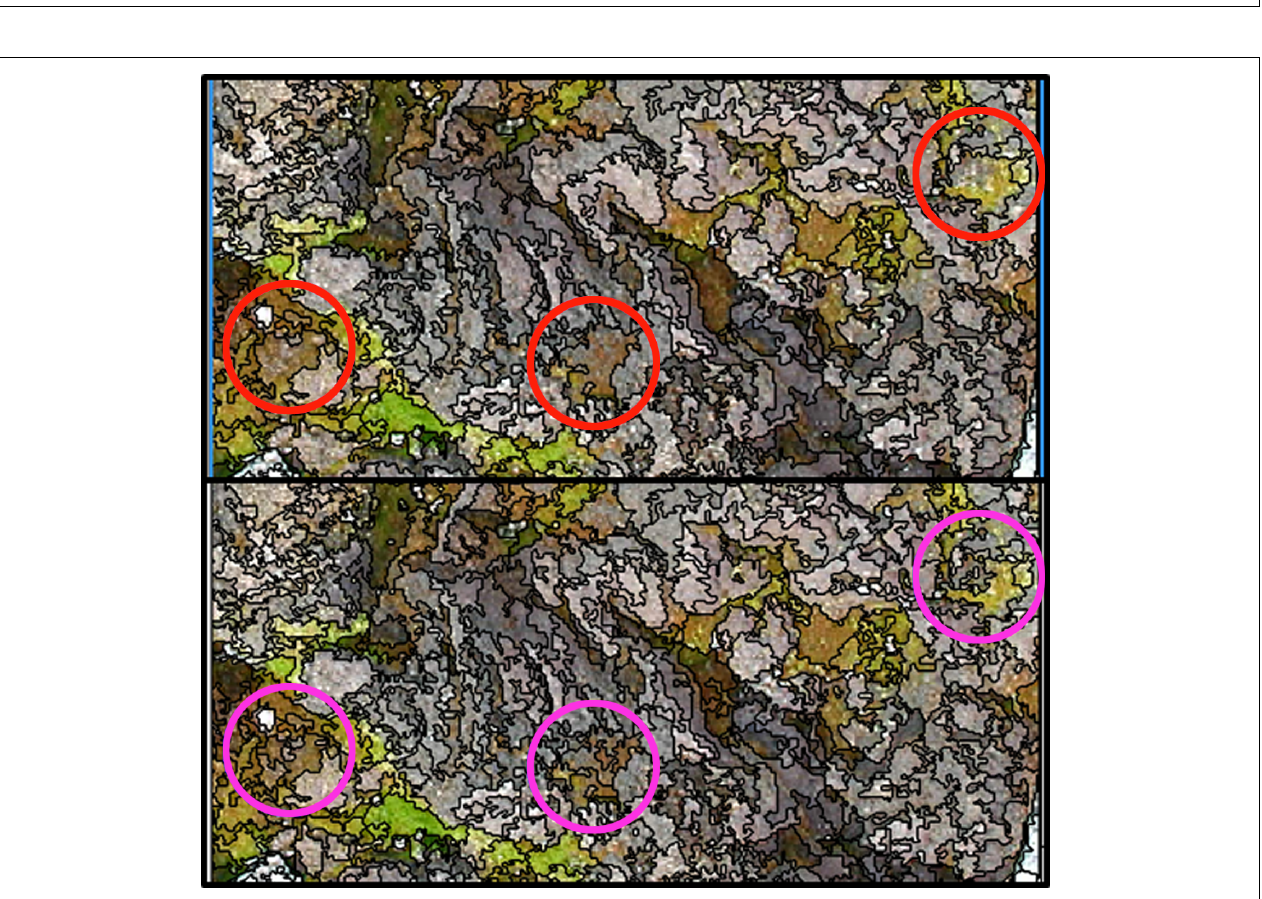
FIGURE 3 | Comparison of scale parameters 33 (top) and 27 (bottom). Scale 27 was chosen as optimal for image segmentation, as it separated out the smaller areas of healthy, stressed and moribund moss, which formed mixed objects when the image was segmented with scale 33, as seen in the three circled areas.